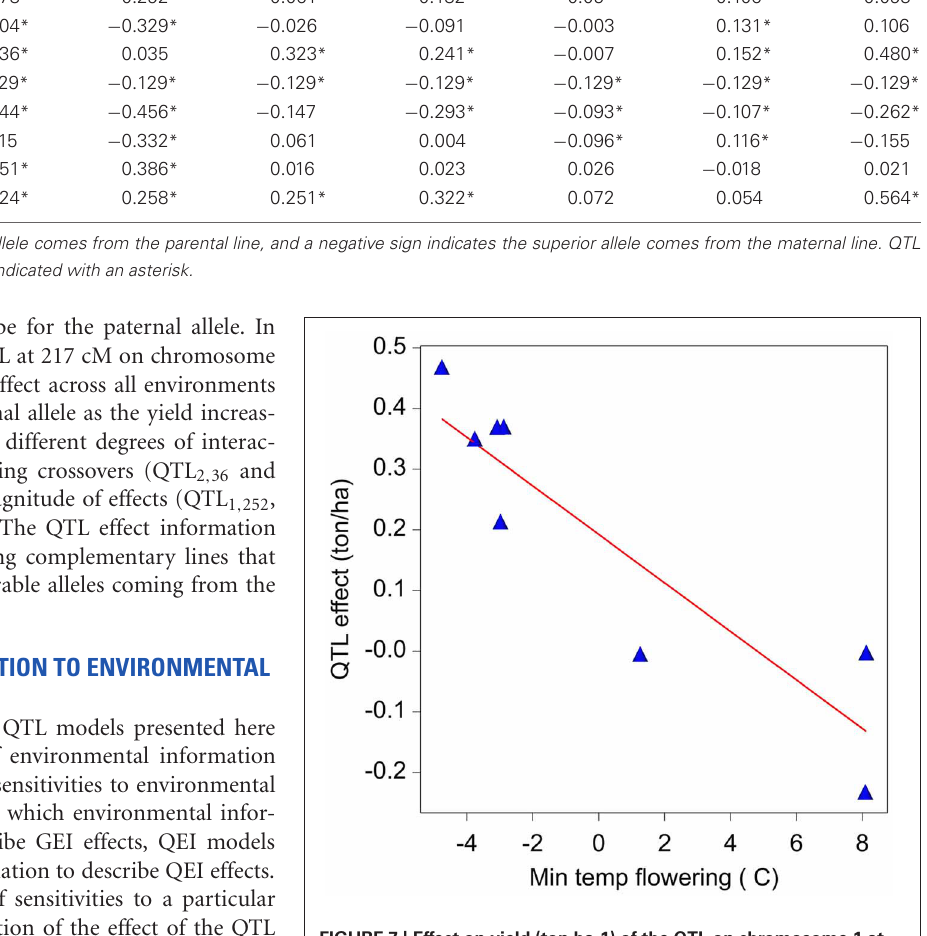
FIGURE 7 | Effect on yield (ton ha-1) of the QTL on chromosome 1 at 141cM in relation to the minimum temperature ( ◦ C) during flowering